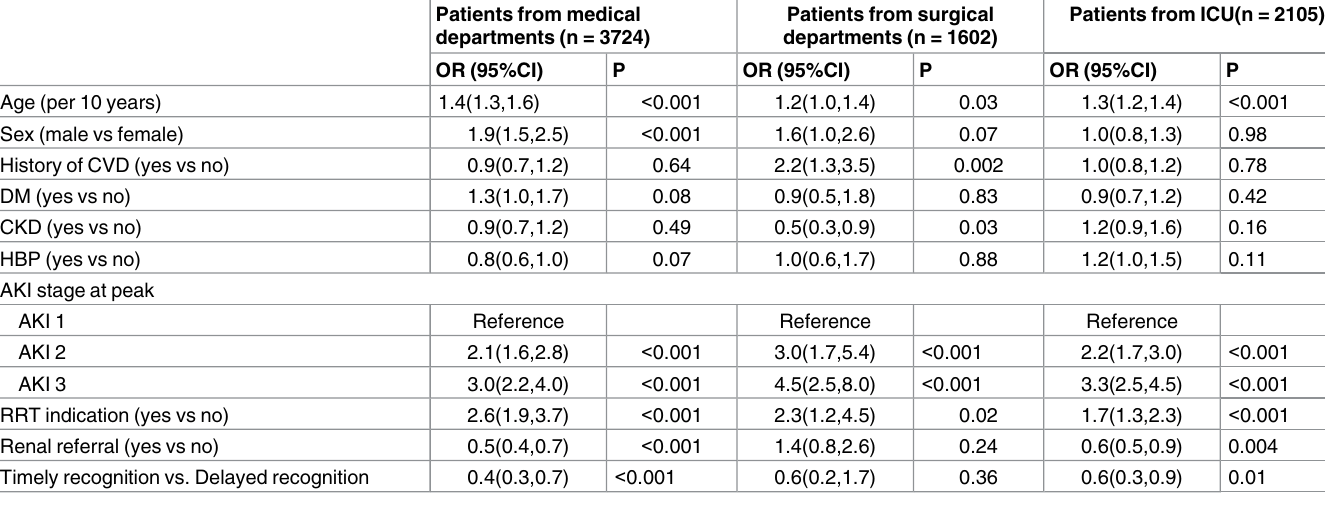
Table 2. Multivariate logistic regression analysis for factors associatedwith all-cause in-hospital mortality in AKI in different clinical departments *